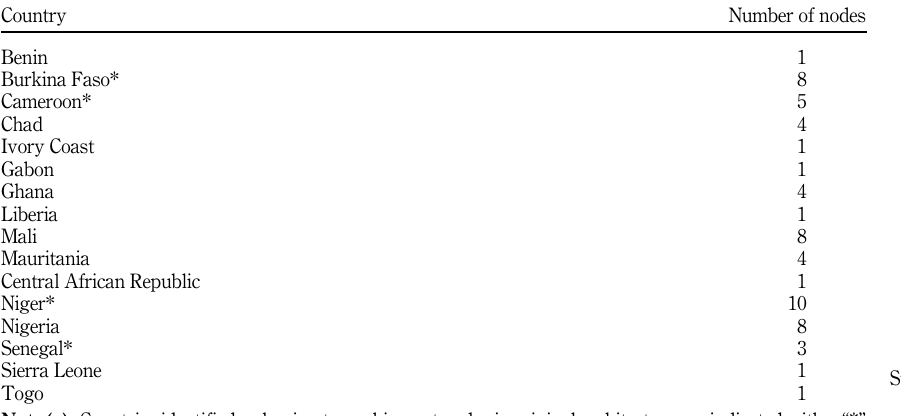
of 61 total demand